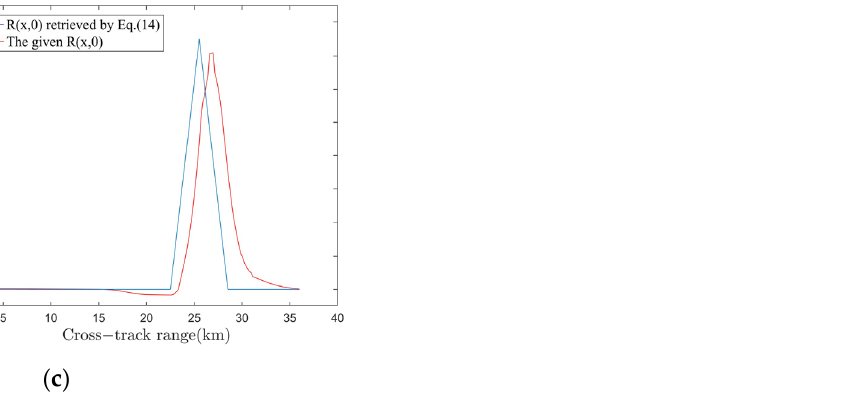
Figure A1. Retrieval effect of Equation (14). ( a ) Surface rain distribution on rectangular rain; ( b ) surface rain distribution on trapezoidal rain; and ( c ) surface rain distribution on triangular rain.